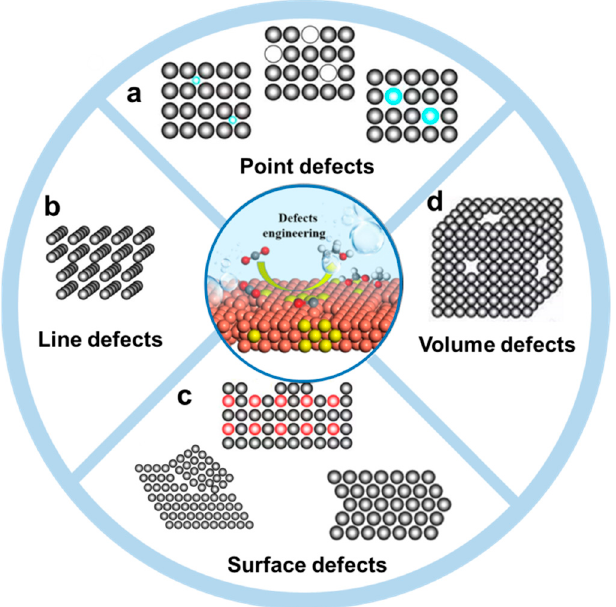
Figure 1. Schematic illustration of various defects in metal nanomaterials. ( a ) Point defects, ( b ) line defects, ( c ) surface defects and ( d ) volume defects.